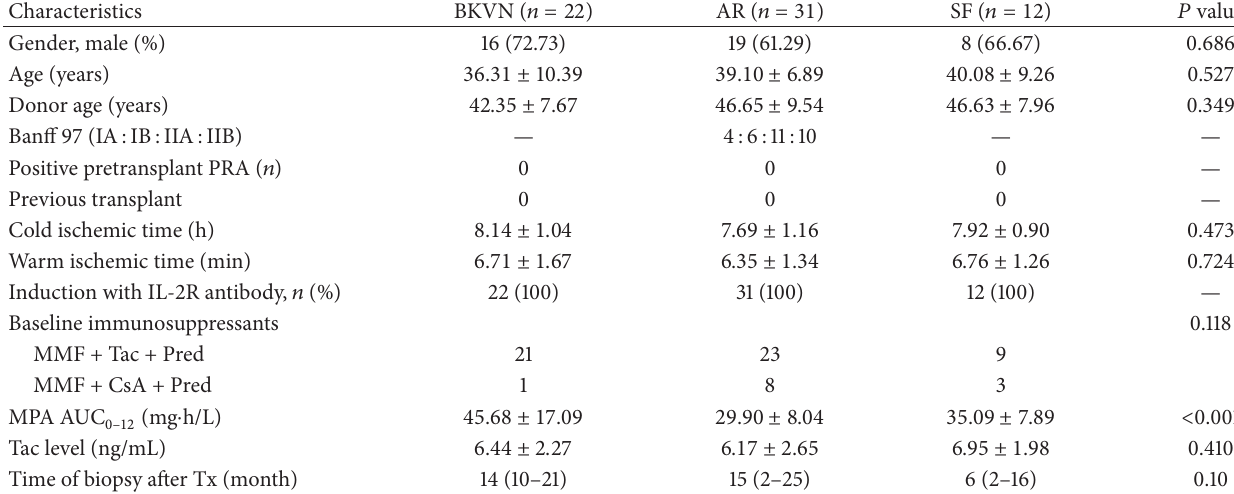
Table 1: Clinical characteristics of patients that participated in this